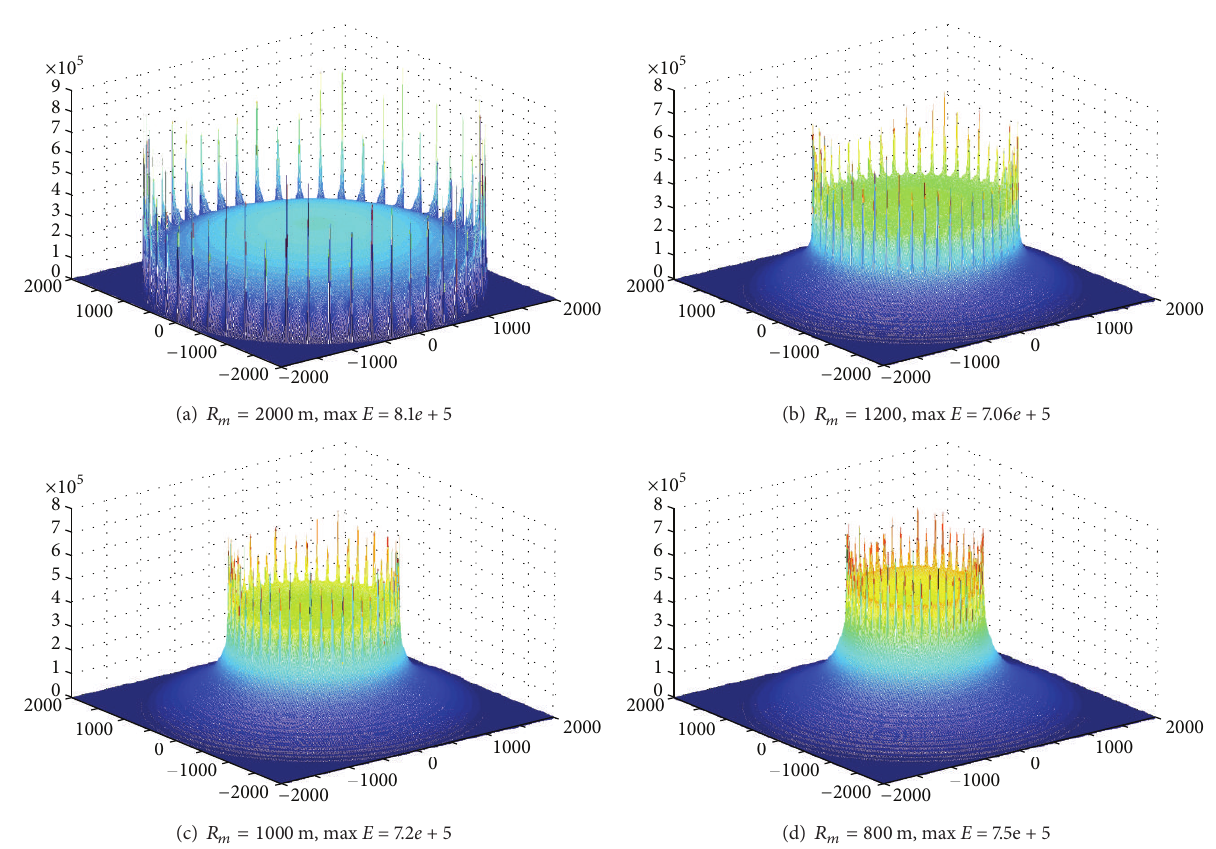
Figure 11: Energy consumption for different values of 𝑅 𝑚 ( 𝑅 = 2000 , rounds = 50 , anchors = 50 , 𝑟 = 85